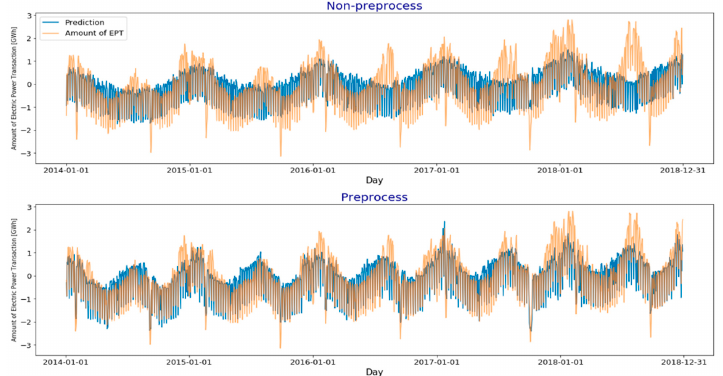
Figure 27. Comparison of predictive amount of EPT.